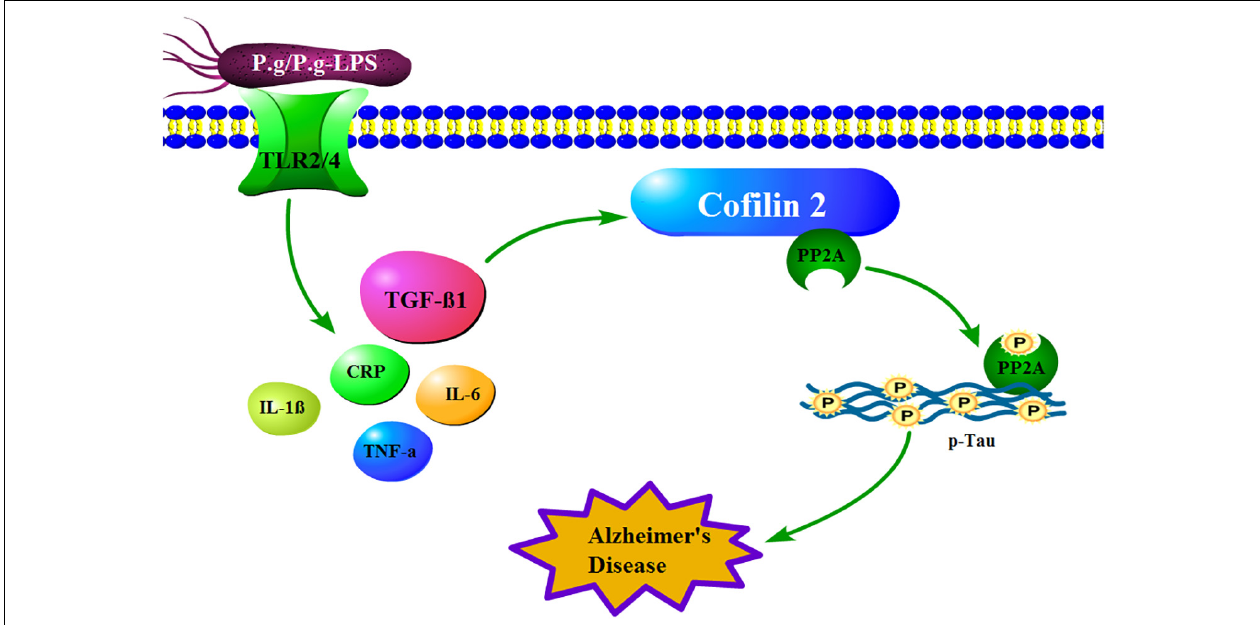
FIGURE 7 | How mechanistically Cofilin 2 acts as an inflammatory linker between CP and AD. In the context of CP, P.g-LPS interacts with Toll like receptor 2/4 and subsequently increases the level of TGF- β 1, which induces the protein expression of Cofilin 2 at transcription level. The latter binds and inhibits the activity of PP2A, which leads to the increase of the phosphorylation level of intracellular Tau and eventually induces the pathological changes of AD.